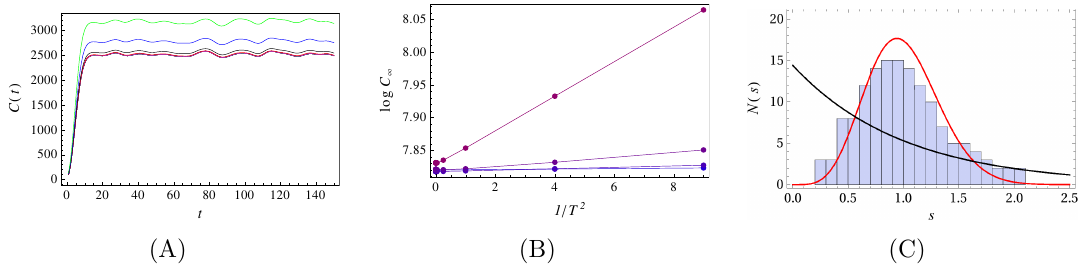
Figure 10. (A) Time dynamics C ( t ) for the truncated quantum-mechanical mini-BMN model, with ν = 0 . 1 , 0 . 3 , 0 . 5 , 1 . 0 (red, black, blue, red), shows the expected pattern of growth followed by an oscillating plateau. (B) Temperature dependence of the saturated value C ∞ ( T ) for the same values of ν (blue to red) has the same exp(1 /T 2 ) scaling as the random matrix ensembles. The level spacing statistics, shown in (C) for ν = 0 . 5 , is indeed quite close to the Gaussian unitary ensemble (full red curve) and clearly at odds with the Poisson statistics (full black curve), confirming that this system is within the scope of our random matrix